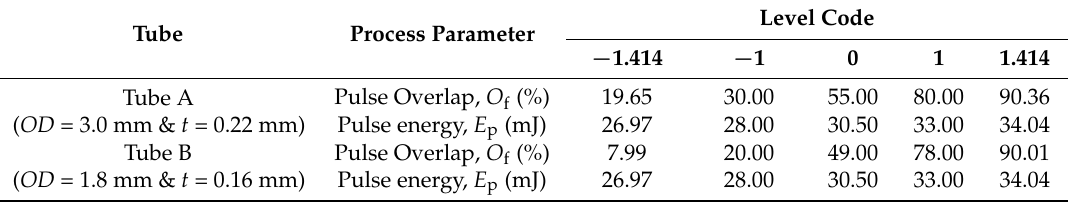
Table 4. Process parameters for experimentation without gas blowing through the tube.